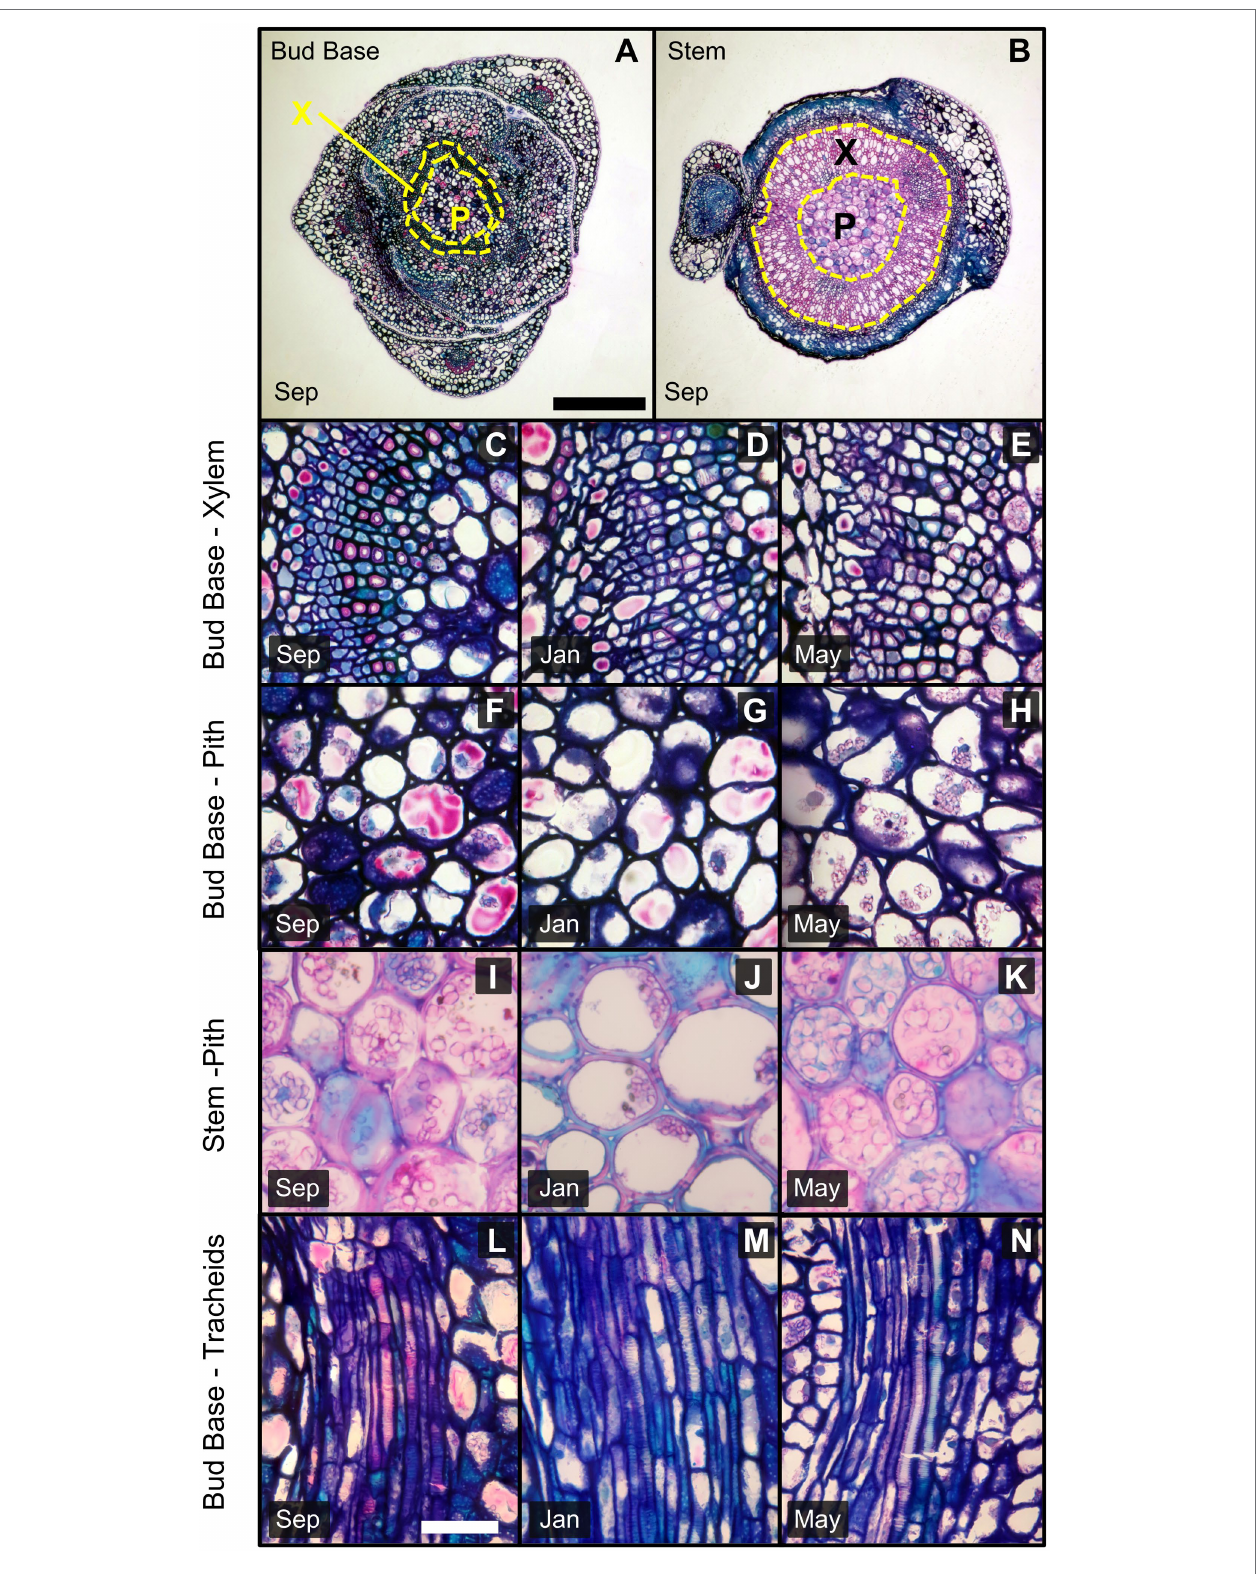
FIGURE 4 | Images of transverse and longitudinal sections of the bud base and stem of Vaccinium macrocarpon shoots. Sections were stained with methylene